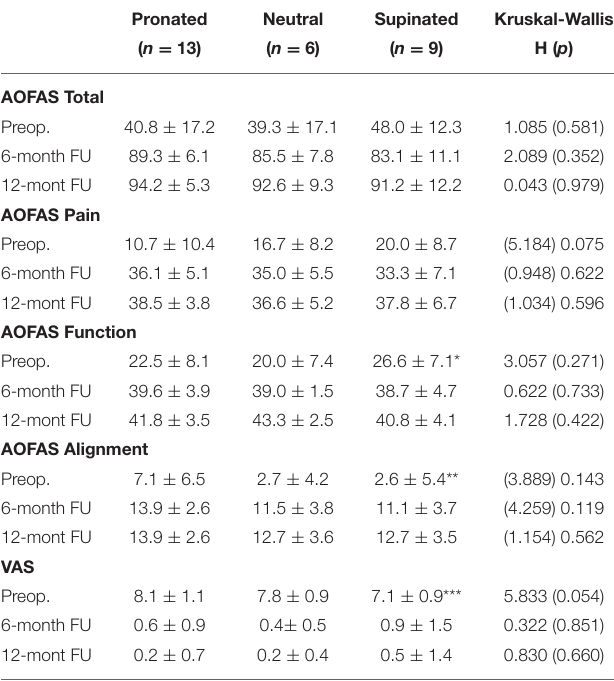
TABLE 2 | AOFAS scores and metatarsal pain assessed by the VAS according to foot type. Pronated Neutral Supinated